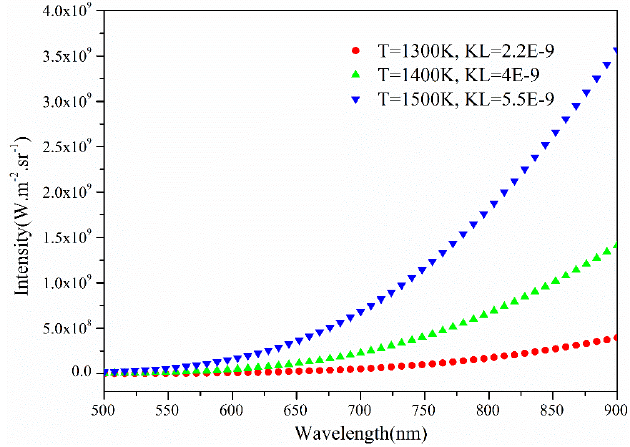
Figure 1. Simulated continuous spectral baseline.